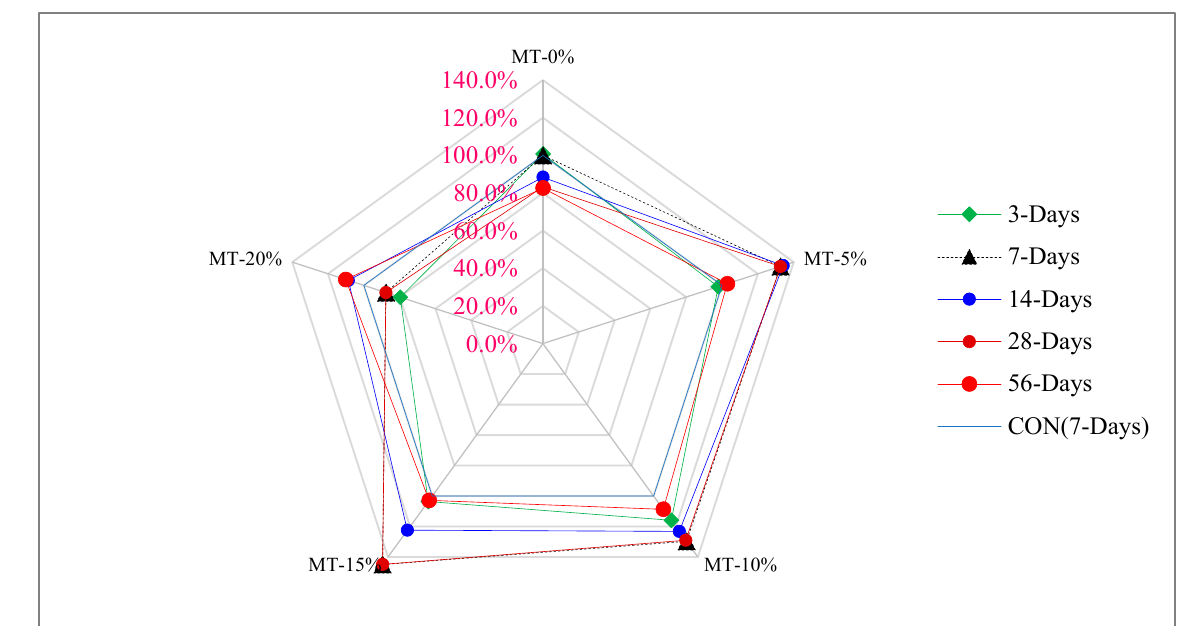
Figure 8. Flexure strength–age relationship: data source [55]. Table 4. Summary of mechanical performance of UHPC.